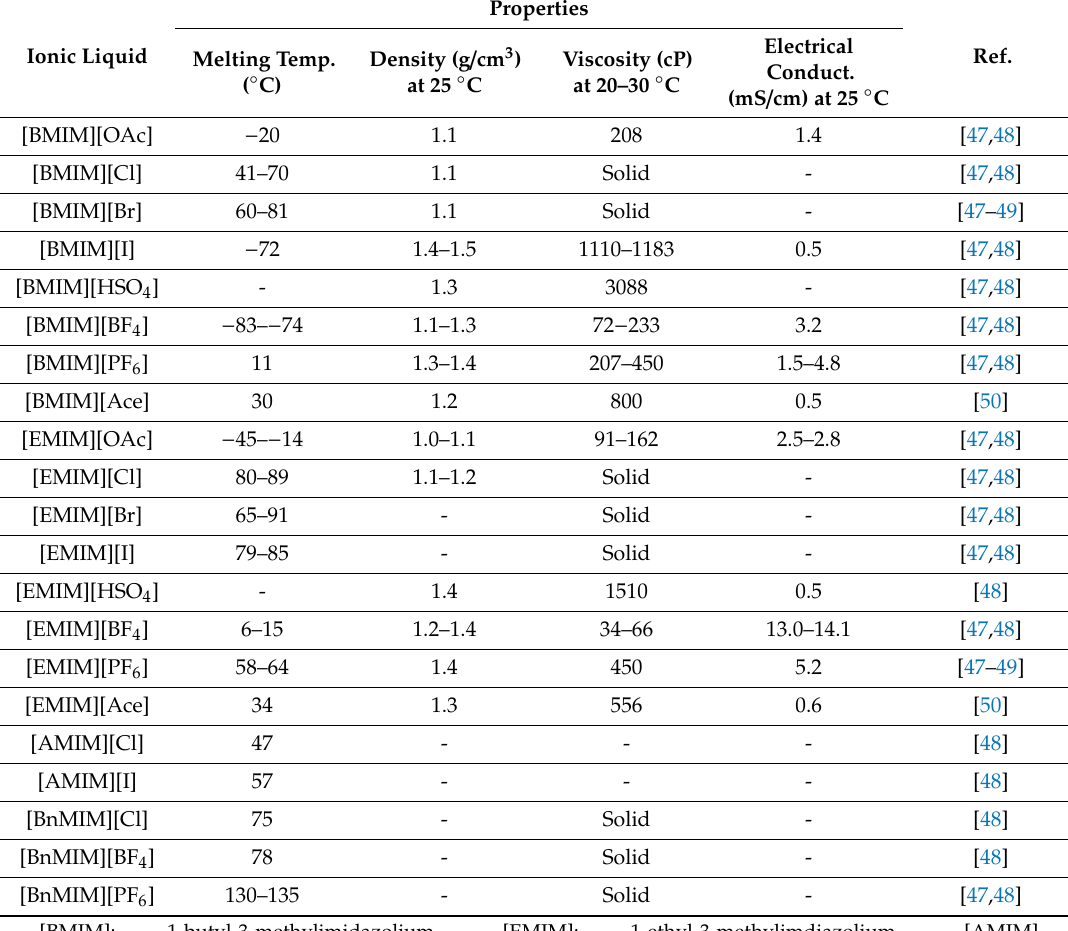
Table 1. Summary of the most commonly used imidazolium ionic liquids for wood and cellulose dissolution and fractionation and their physicochemical